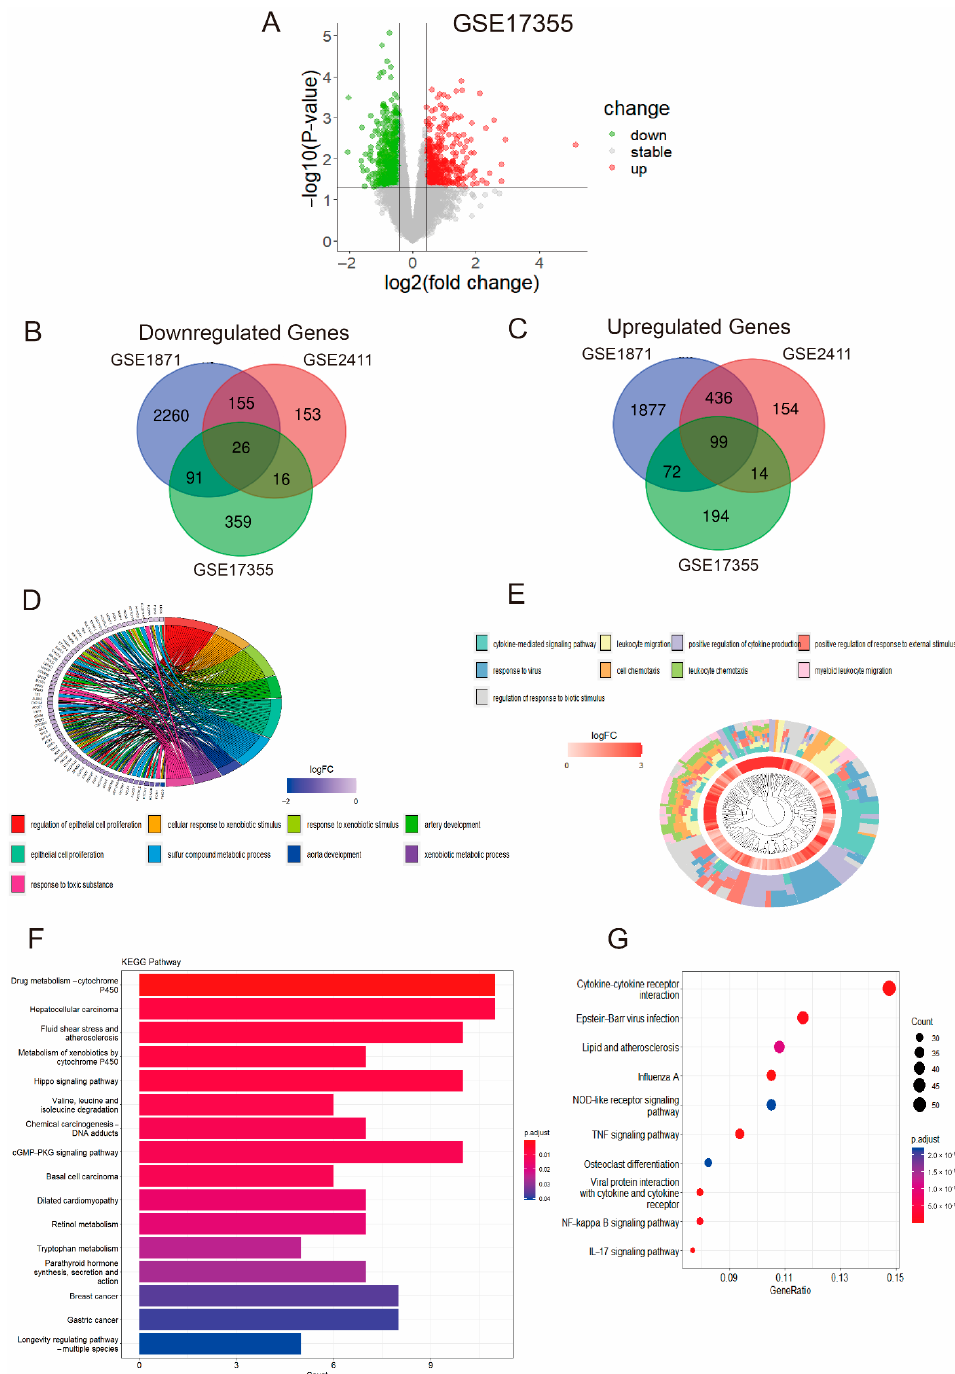
Figure 2. Differentially expressed genes and enrichment analysis in ALI. ( A ) Volcano plot show- ing DEGs between ALI and normal lung tissue in GSE17355, where red dots indicate upregulated genes, green dots indicate downregulated genes, and gray dots indicate stable genes (corrected p values < 0.05). ( B ) Venn diagram of downregulated overlapping genes in the three datasets. ( C ) Venn diagram of upregulated overlapping genes in the three datasets. ( D ) The top nine sig- nificant GO terms involving the downregulated overlapping genes. ( E ) The top nine significant GO terms involving the upregulated overlapping genes. ( F ) KEGG pathway analysis of downregulated overlapping genes revealed the top 16 relevant pathways. ( G ) KEGG pathway analysis of upregulated overlapping genes revealed the top ten relevant